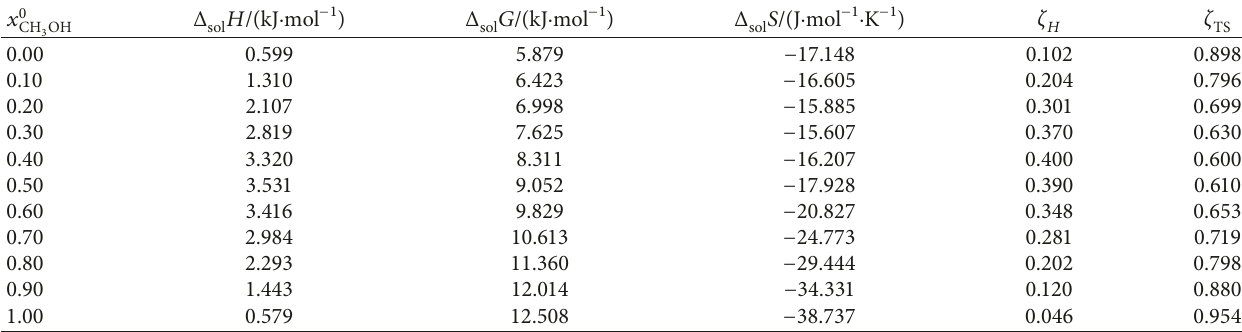
3 OH-H 2 O binary system.